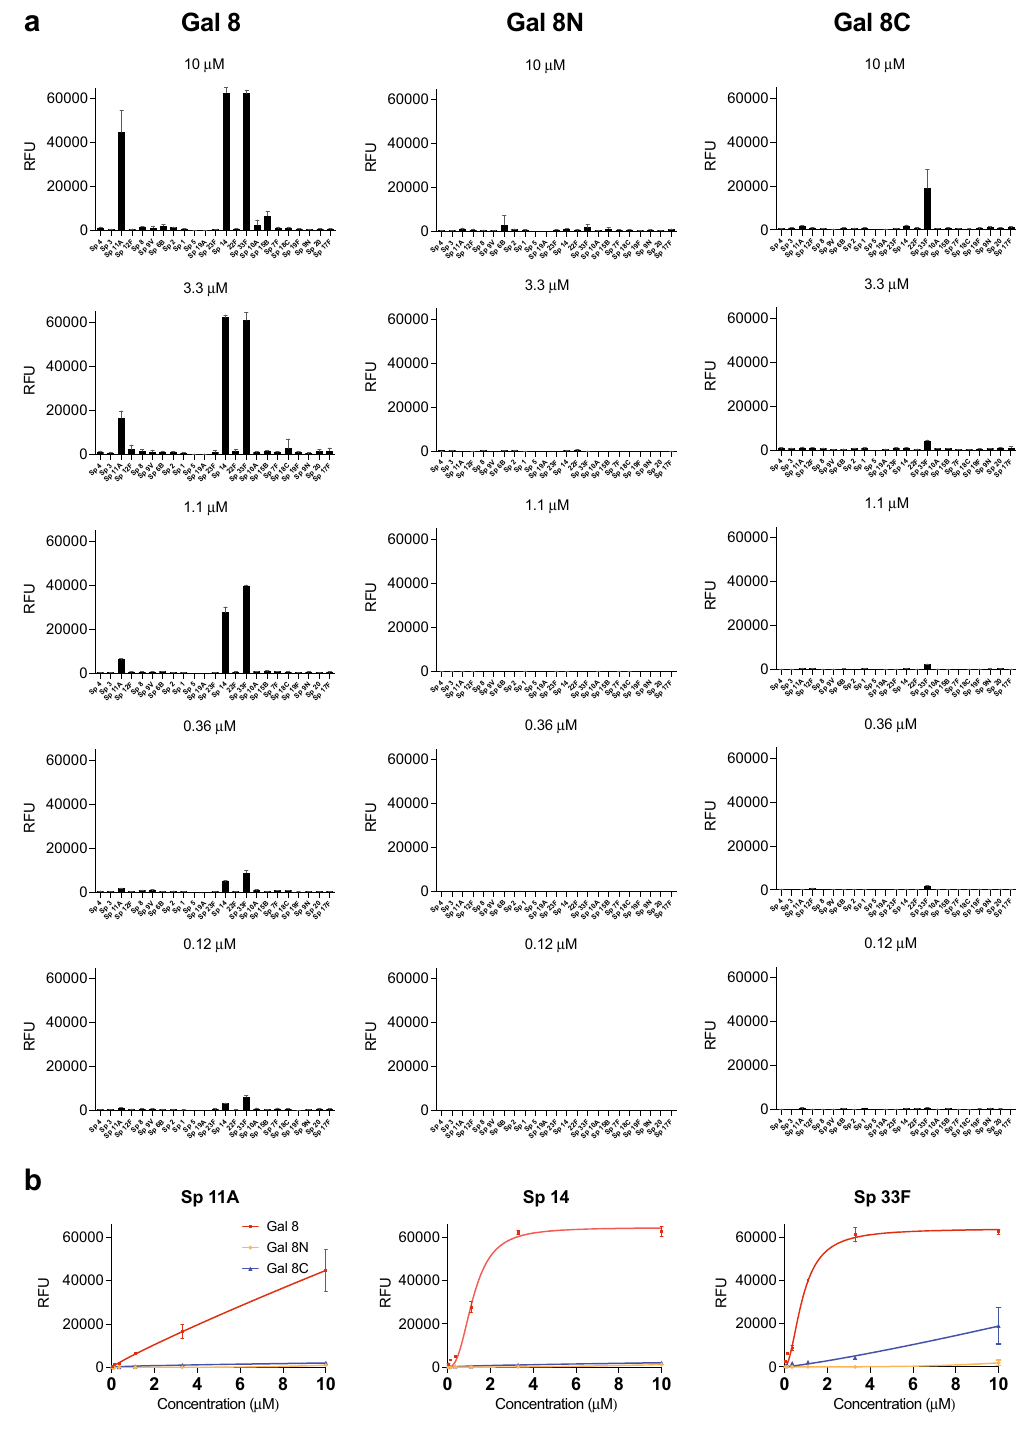
Figure 1. Gal-8 recognize S. pneumoniae that express self-like antigens on the microbial glycan microarray (MGM). ( a ) MGM array was incubated with Gal-8, Gal-8N and Gal-8C at the concentrations indicated. Error bars represent means ± standard deviation (SD). RFU, relative fluorescence units. S. pneumoniae Danish type 11A; Sp 11A, S. pneumoniae Danish type 14; Sp 14, S. pneumoniae Danish type 33F; Sp 33F. ( b ) Selected microbial glycans represented on the MGM were shown with binding isotherms. Error bars represent means ±